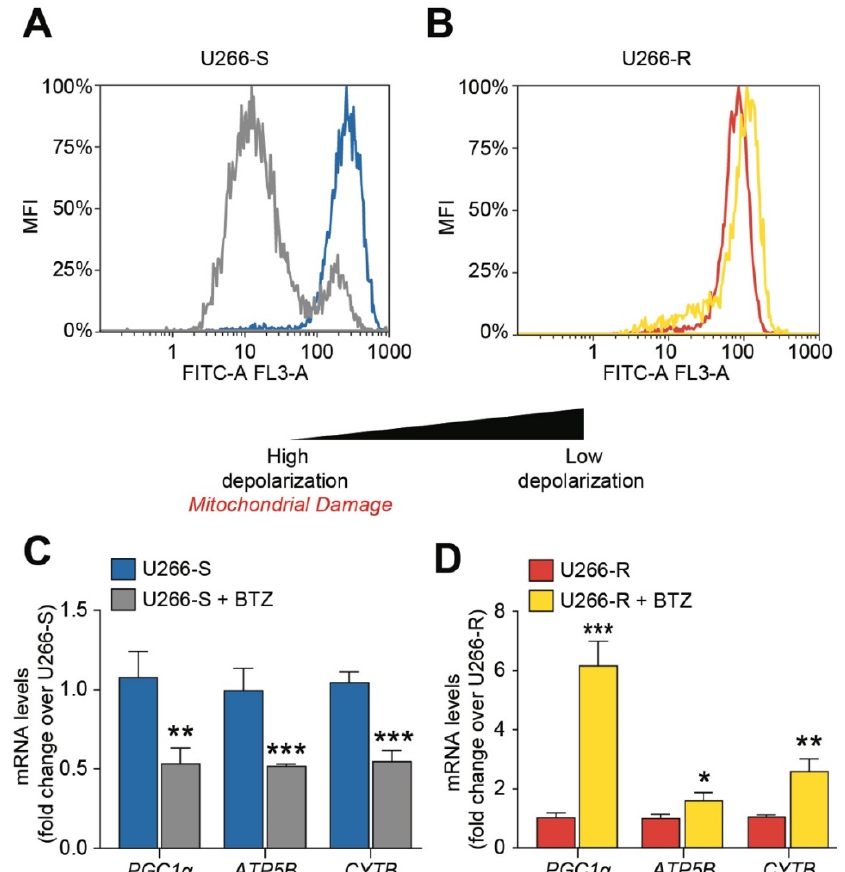
Figure 3. Mitochondrial fitness after bortezomib (BTZ) challenge contributes to drug resistance. ( A , B ) Representative plots of mitochondrial depolarization in untreated U266-S and U266-S + BTZ ( A ) and untreated U266-R and U266-R + BTZ ( B ). ( C ) mRNA levels of PGC1 α , ATP synthase (ATP-synt) and CytB in untreated U266-S and U266-S + BTZ cell lines; data are fold changes over untreated U266-S and expressed as mean ± SEM of n ≥ 3 biological replicates; ** p -value < 0.01 and *** p -value < 0.001 versus U266-S. ( D ) mRNA levels of PGC1 α , ATP-synt and CytB in untreated U266-R and U266-R + BTZ cell lines; data are fold changes over untreated U266-R and expressed as mean ± SEM of n ≥ 3 biological replicates; * p -value < 0.05, ** p -value < 0.01 and *** p -value < 0.001 versus U266-R.